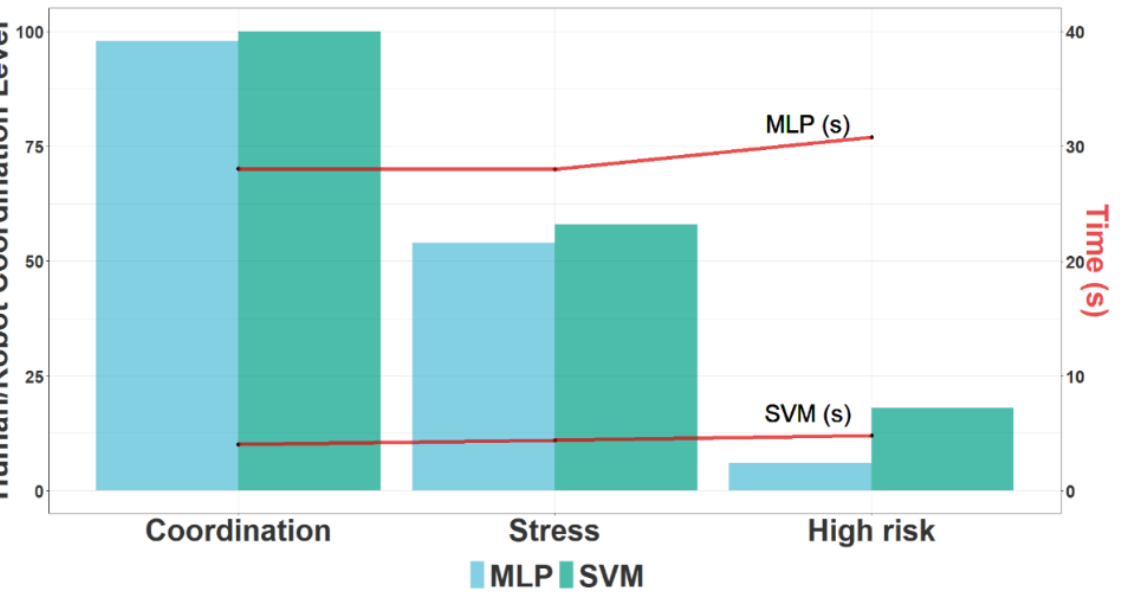
Figure 11. Results of Human/Robot Coordination Level for the three Uses Cases and two classifiers (MLP and SVM): UC1: Coordination, UC2: Stress, UC3: High risk. The lines in “red” indicate the Model Time for each classifier.